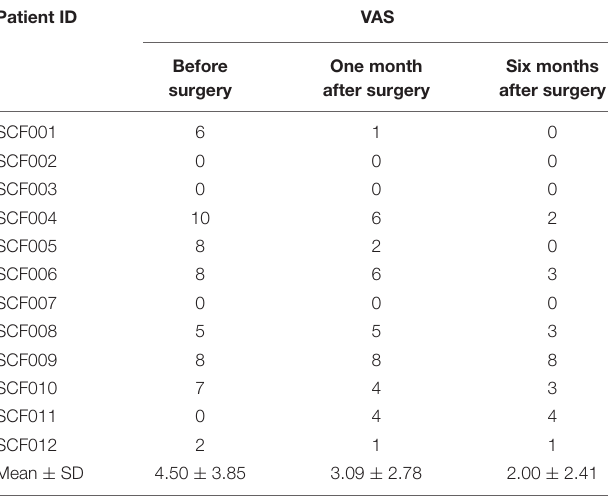
TABLE 3 | Visual analog scale for cord central pain in paraplegic patients. Patient